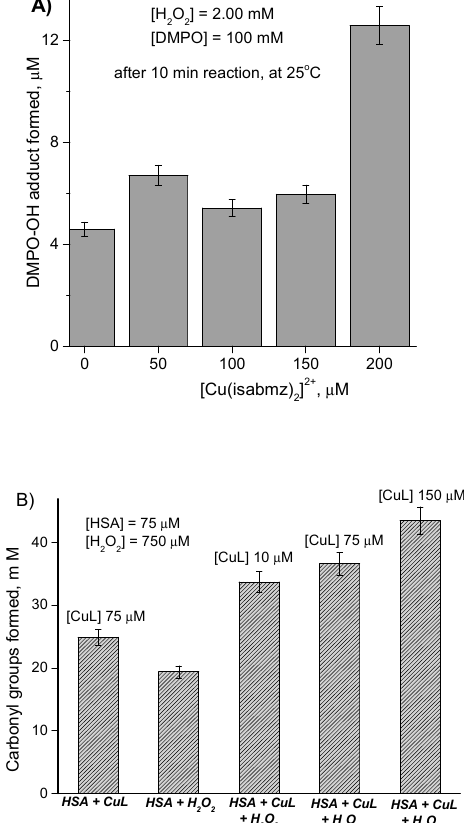
Figure 2. ( A ) Double integrated signal of 5,5-Dimethyl-1-pyrroline N-oxide (DMPO)–OH adduct detected by EPR spectroscopy after 10 min reaction in phosphate buffer at pH 7.4, at room temperature, using DMPO (100 mM) as spin trap, in the presence of complex [Cu(isambz) 2 ] 2+ 1 (50 to 200 μ M) and H 2 O 2 (2.0 mM); ( B ) Oxidative damage to human serum albumin (HSA, 75 μ M) induced by complex [Cu(isambz) 2 ] 2+ 1 after incubation for 30 min at 37 °C in the presence of hydrogen peroxide (750 μ M), monitored by the formation of carbonyl groups in the protein.